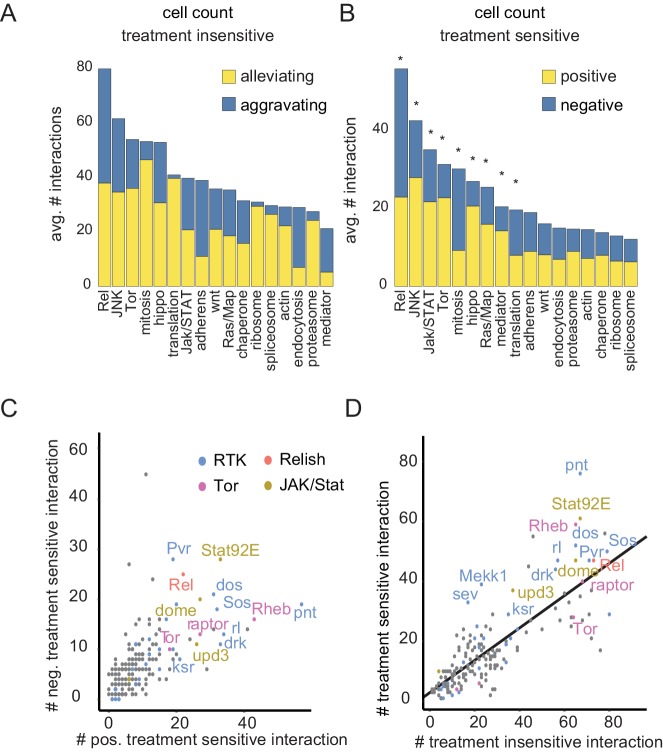
Drug sensitive genetic interactions are enriched for stress responsive signaling pathways (A–B) Distribution of aggravating/alleviating treatment-insensitive (A) and positive/negative treatment-sensitive (B) interactions among molecular pathways. Binomial testing estimated if counts were expected by chance (*=FDR < 0.1). (C) Gene-level interaction counts. Counts of significant, unique negative treatment-sensitive interactions compared to counts of positive treatment-sensitive interactions. Dots are colored by functional groups. Pathways with the most treatment-sensitive interactions (Tor, Ras, Rel and Jak/STAT signaling) are highlighted. (D) Counts of treatment-insensitive interactions are plotted against treatment differential interaction counts. A trendline indicates a general linear dependency between treatment-insensitive and treatment-sensitive interaction counts. (A–D) Count data are based on cell number feature, significant (FDR < 0.3), MODIFI modelled interactions.